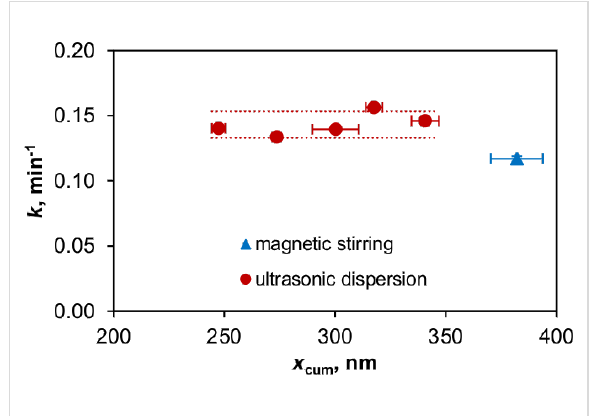
Figure 6: Dependence of MB discoloration in 1 g/L P25 suspensions on the photocatalyst aggregate size achieved by ultrasonic dispersion and magnetic stirring. The experiments were repeated twice, and the error bars indicate the span between the minimum and maximum values, and the upper and lower bands indicate the t-confidence inter- vals of 95%.